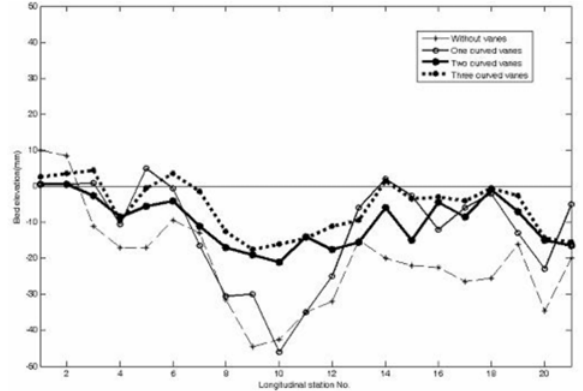
Fig. 15. Longitudinal bed profiles 3-cm from outer bank of curved vanes in in zigzag pattern on 1800-bend.